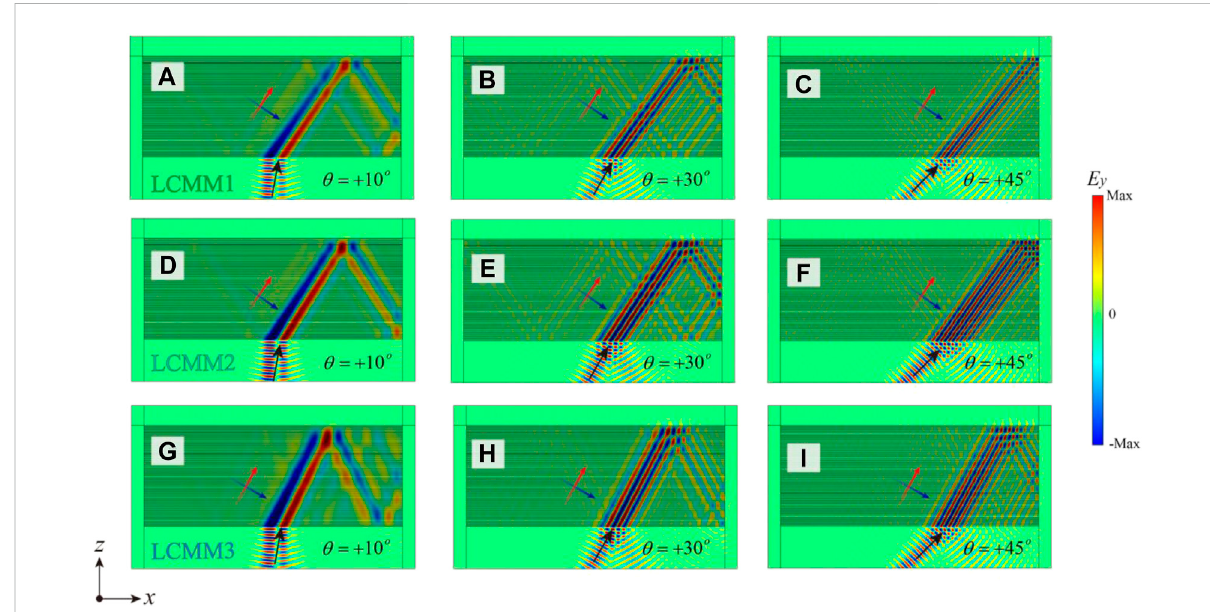
FIGURE 8 DirectionalrefractionoftheMLCMM basedonthestep-like multilayer structure. (A – C) Thepositive refractionofLCMM1withdifferentincident angles: (A) θ (cid:1) + 10 o , (B) θ (cid:1) + 30 o , (C) θ (cid:1) + 45 o . (D – F) (G – I) Similar to (A – C) , but for the LCMM2 and LCMM3,